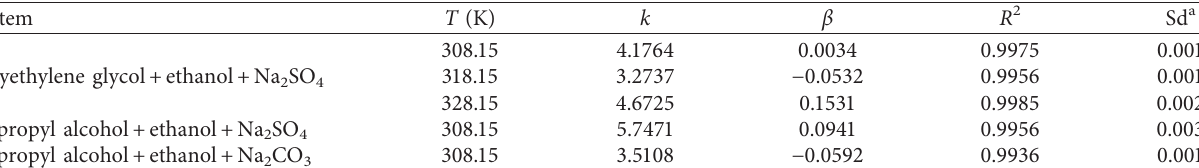
2 CO 3 /Na 2 SO 4 )+water